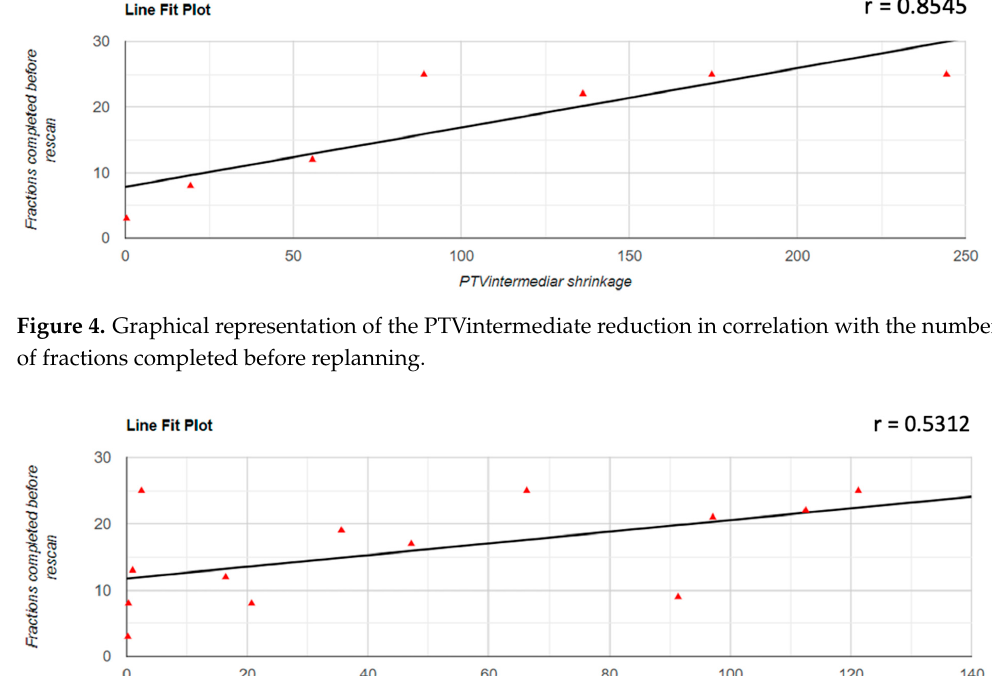
Figure 3. Graphical representation of the PTVlow reduction in correlation with the number of frac- tions completed before replanning.